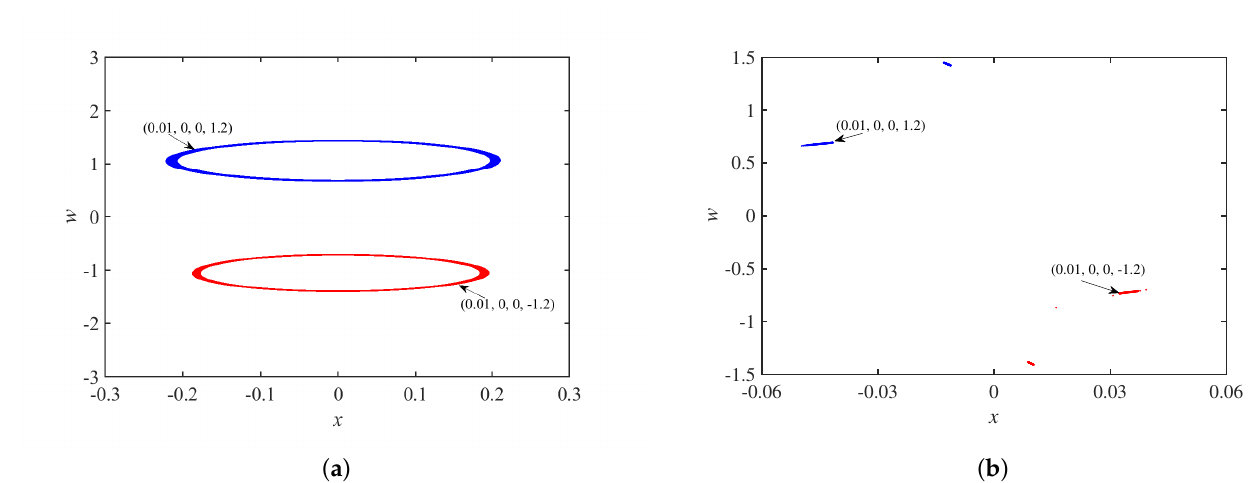
Figure 19. When ϕ ( 0 ) = ± 1.2: ( a ) coexisting periodic limit cycle; ( b ) Poincaré